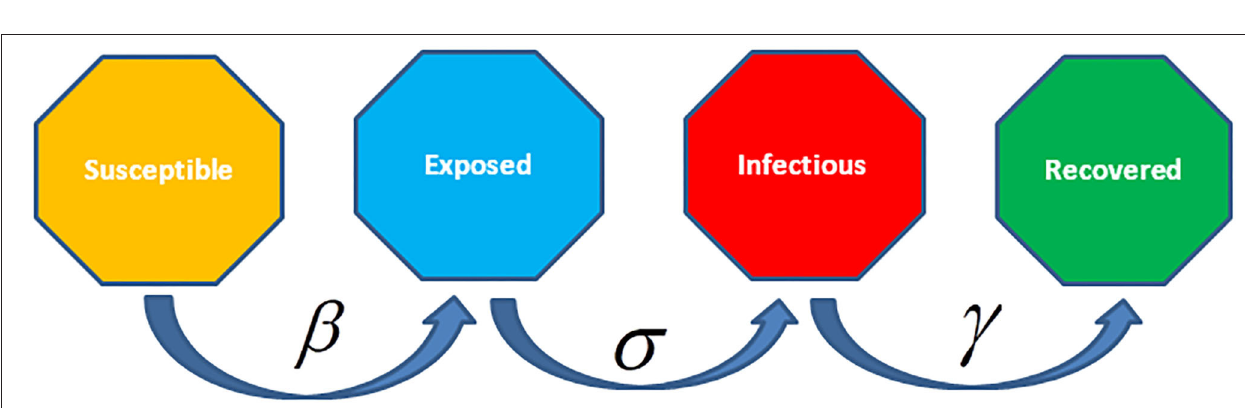
FIGURE 10 | The Susceptible-Exposed-Infected-Recovered (SEIR) model is an extension of the SIR model to include an exposed but non-infectious group of individuals. This model considers the number of susceptible, exposed, infectious, and recovered individuals with no additional mortality associated with infectious